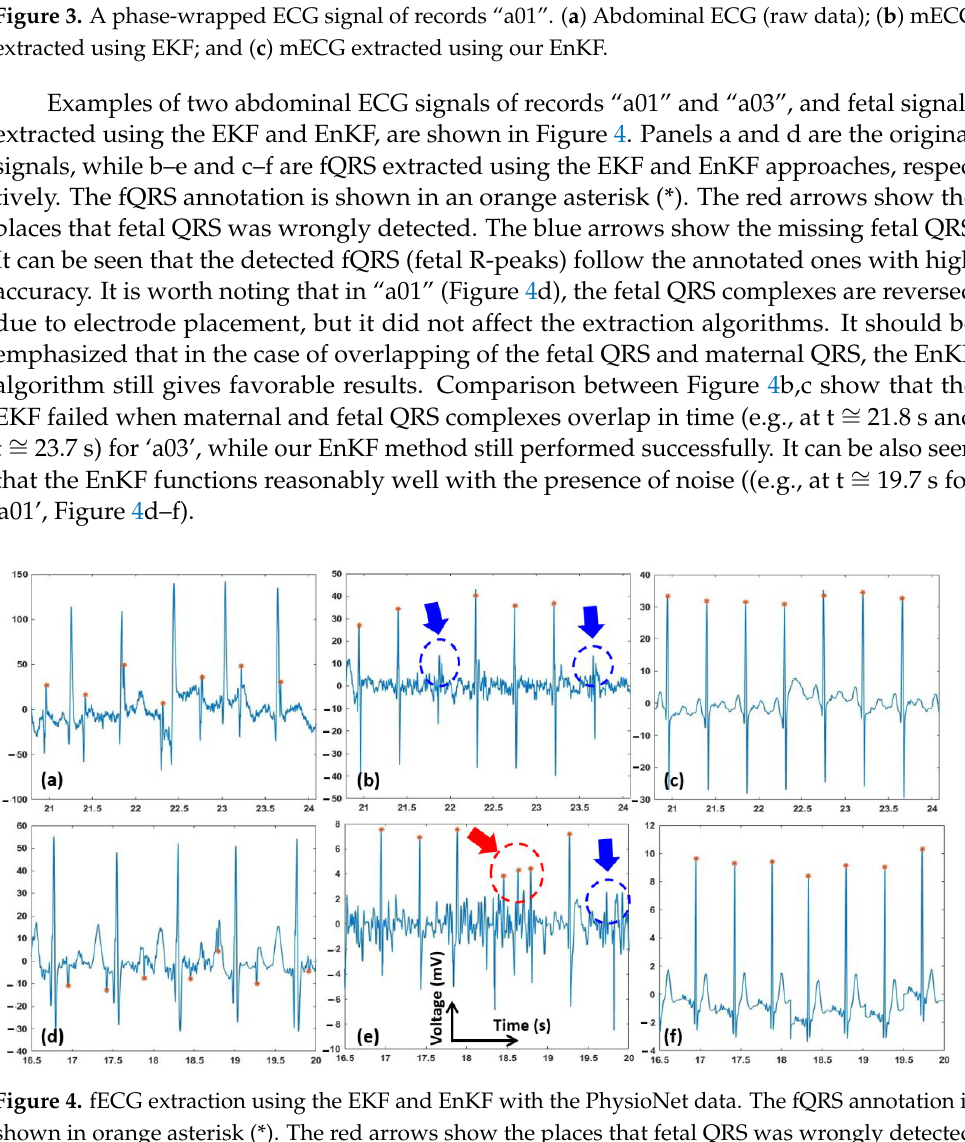
Figure 5. fECG extraction using the EKF and EnKF with the motion artifacts added PhysioNet data. The fQRS annotation is shown in orange asterisk (*). The red arrows show the places that fetal QRS was wrongly detected. The blue arrows show the missing fetal QRS. ( a ) Abdominal ECG (raw data); ( b ) fECG extracted using EKF; and ( c ) fECG extracted using EnKF. Figure 6 shows the performance of the proposed algorithm, the EnKF, and the EKF on one sample from our clinical data. Panels a–c show the original and extracted signals, while panels d–f are signals with extensive preprocessing. Specifically, in Figure 6d, a lowpass filter (with a cut-off frequency of 1 Hz), a notch filter, and a Wavelet filter (a 10 level 1-D stationary wavelet decomposition with Coiflet mother wavelet) were used to suppress the background noise and artifacts. The signal extracted from the preprocessed data with the EKF and EnKF algorithms are shown in Figure 6e,f. In Figure 6f, we also further notice that fetal characteristic waves, such as P and T waves, may be conserved. This judgment is also strengthened by the EnKF extraction carried out on the original